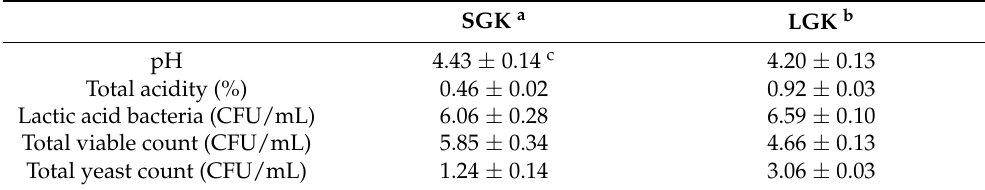
Table 1. Changes in pH, acidity value, and numbers of LAB, total bacteria, and yeast.